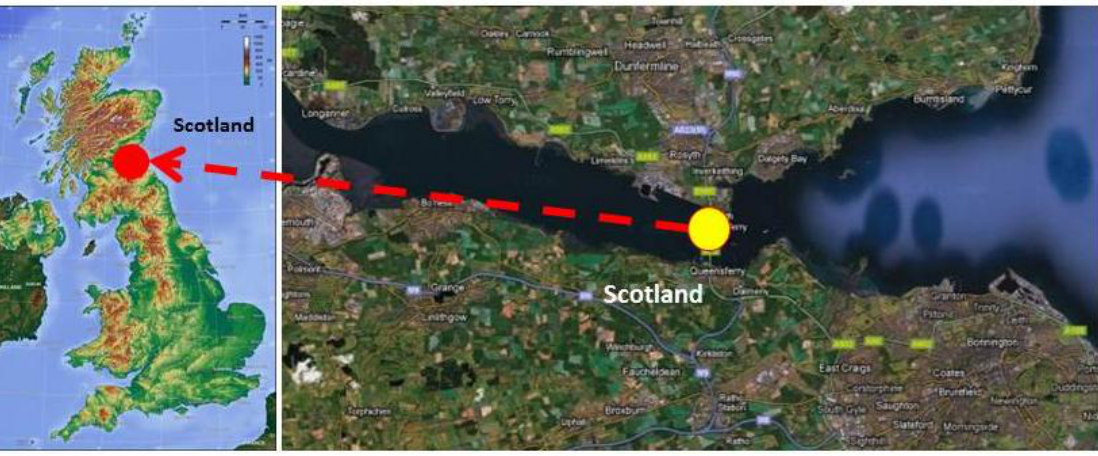
Figure 5. Location of Forth Road Bridge